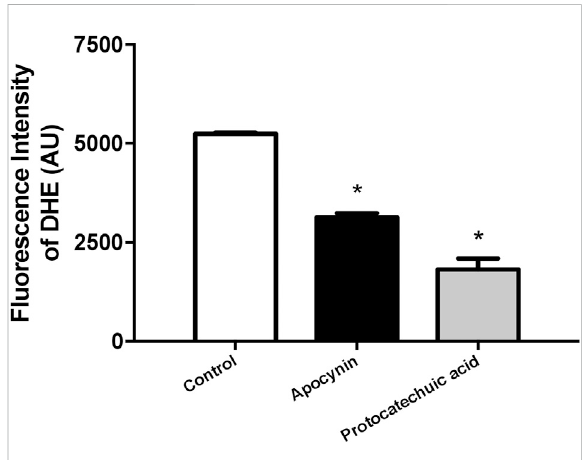
FIGURE 6 Reactive oxygen species (ROS) concentration, in arbitrary units, in human umbilical vein endothelial cells (HUVEC). Fluorescence intensity was detected by ROS-sensitive probe dihydroethidium (DHE) in cells unstimulated (Control, white bars) or stimulated (100 μ mol/L) with apocynin (black bars) or protocatechuic acid (grey bars). Values represent the mean ± SEM of the results, n = 4. * p < 0.05 Apocynin and Protocatechuic acid vs. Control.